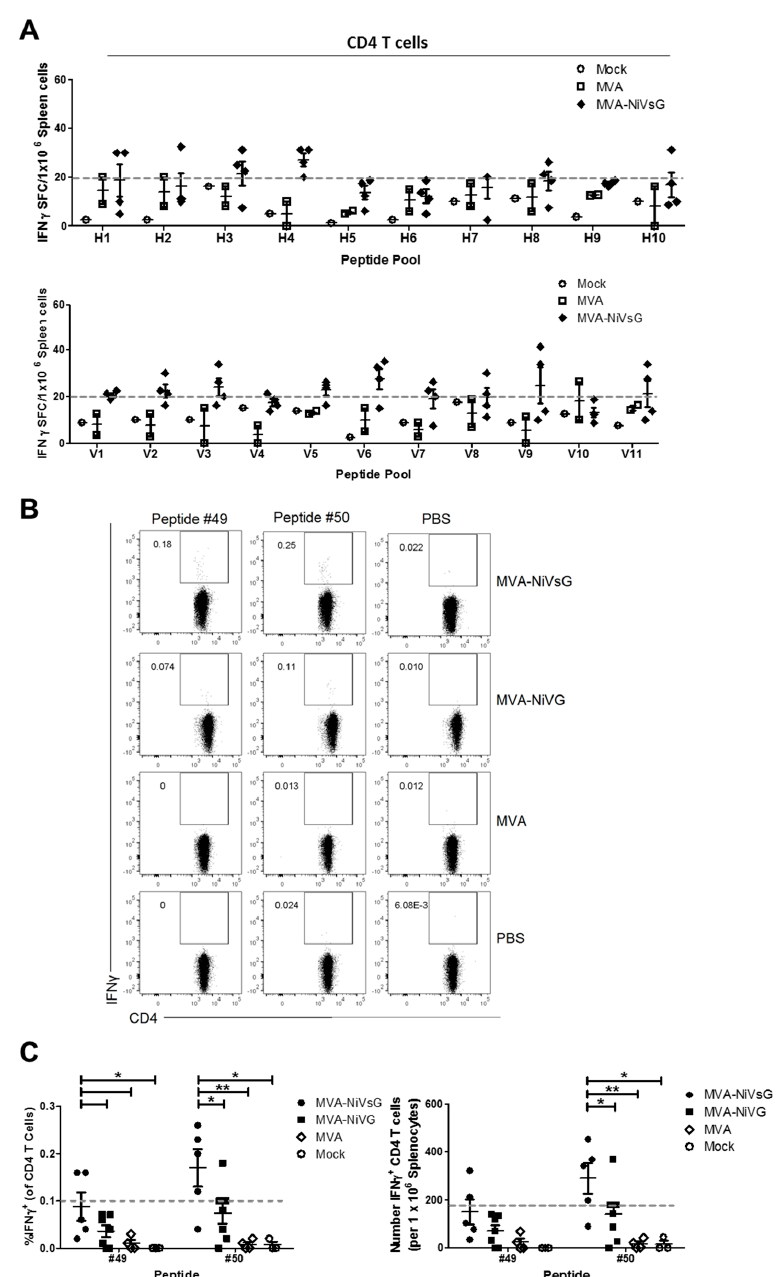
Figure 6. Activation of antigen-specific CD4 T cells after immunization with the recombinant MVA candidate vaccines expressing NiV-G or NiV-sG. Groups of IFNAR − / − mice ( n = 2–7) were immunized twice with MVA–NiVsG, MVA–NiV-G, MVA, or saline (mock) via the i.p. or i.m. route over a 21 day period. Eight days after the final immunization, CD4 T cell-enriched splenocytes or total splenocytes were restimulated and measured by IFN- γ ELISPOT assay or IFN- γ intracellular cytokine staining (ICS) plus FACS analysis. ( A ) Screening for H2-IAb-restricted T cell epitopes of NiV-G in CD4 T cell- enriched splenocytes obtained from i.p. immunized mice. T cell responses were measured by IFN- γ ELISPOT assay. Graph shows IFN- γ SFC of CD4 T cell-enriched splenocytes stimulated with peptide